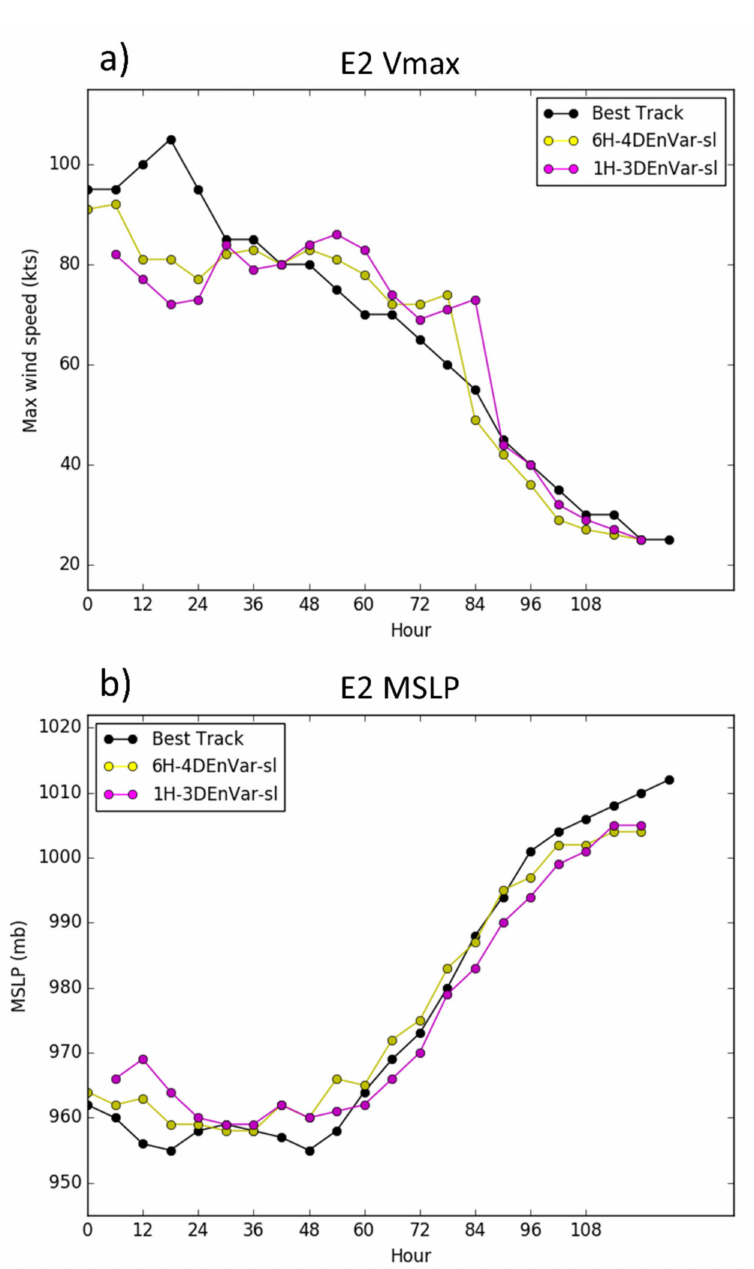
Figure 15. Vmax ( a ) and MSLP ( b ) for E2 using satellite derived locations during